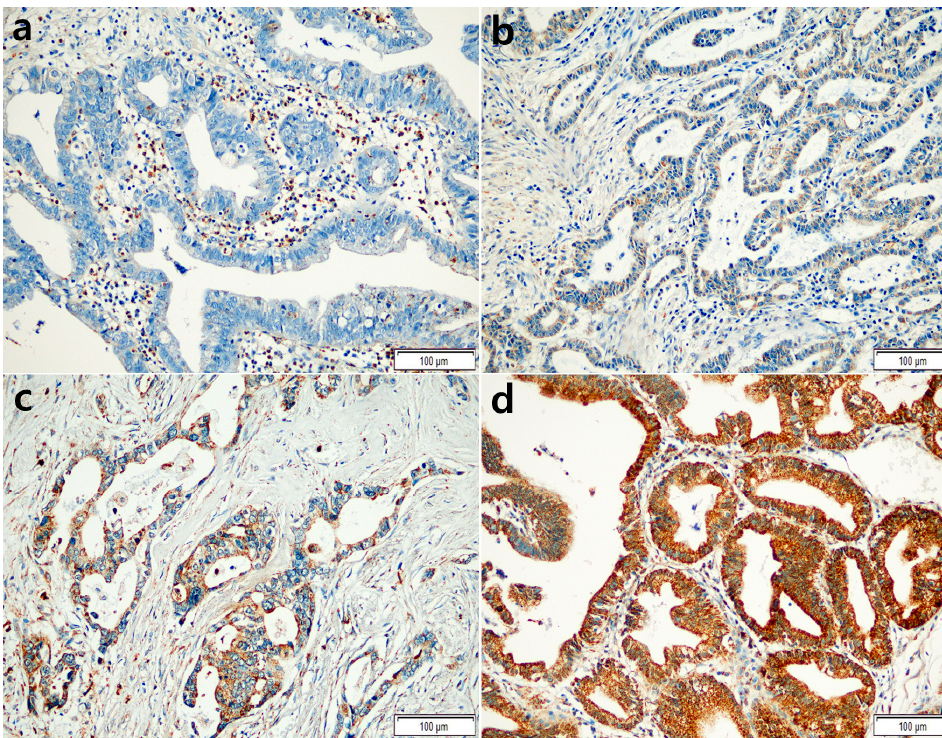
Figure 4. Representative images of immunohistochemistry (IHC) staining with CADM4 in gallbladder cancer (GBC) (×200). Negative ( a ), weak ( b ), moderate ( c ), and strong ( d ) cytoplasmic expression.